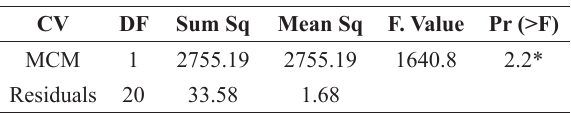
Analysis of the regression models of the MCM variable as a function of the SDIC variable, performed in 22 test images (test